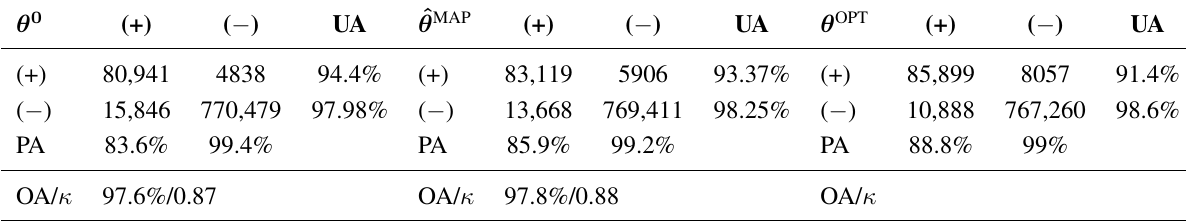
Table 3. Confusion matrices and accuracy measures for the class rapeseed given the threshold θ 0 obtained by the BSVM (left), ˆ θ MAP obtained by Bayes’ rule (middle), and the optimal threshold θ OPT